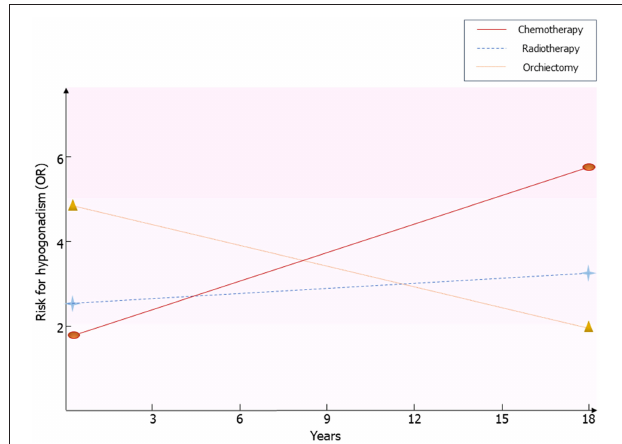
FIGURE 1 | Risk for hypogonadism in testicular tumor survivors. Results coming from the available follow-up studies are resumed. Risk of hypogonadism has been calculated in comparison with healthy men. OR, odds